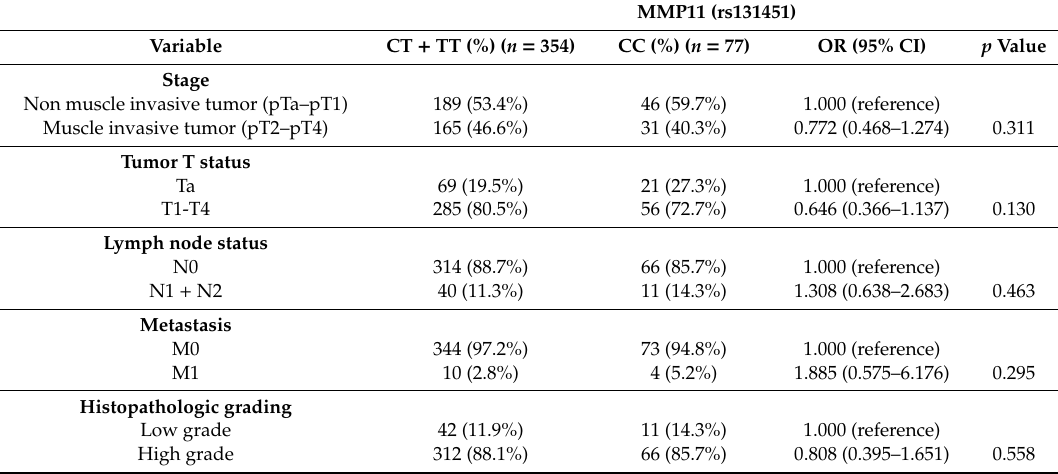
Table 3. Distribution frequency of the clinical status and MMP11 (rs131451) genotype frequencies in 431 UCC patients.